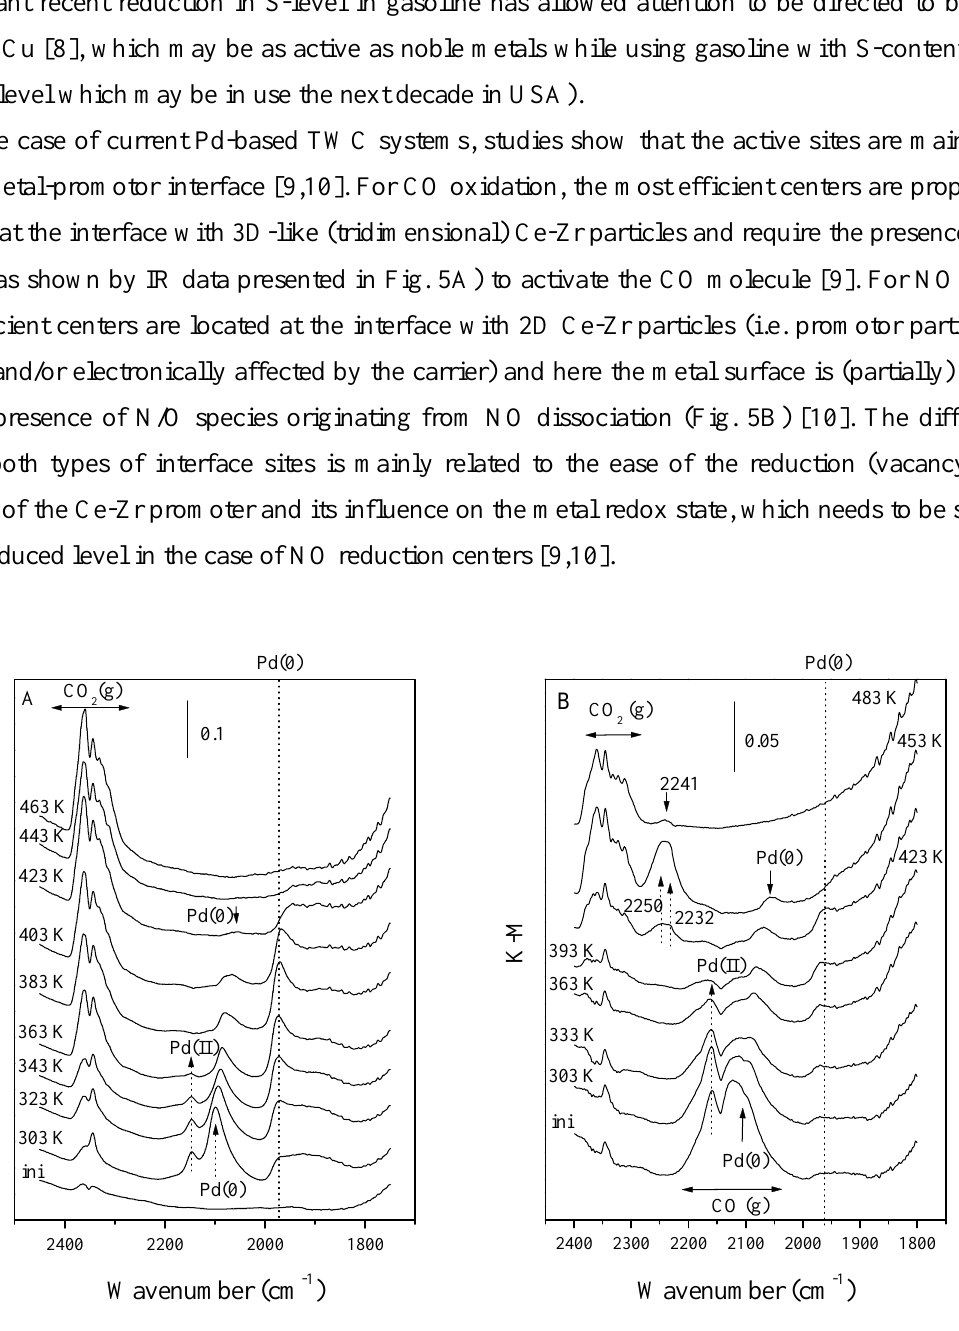
Fig. 5 DRITFS spectra of a PdZCA specimen during reaction: A) CO+O creasing